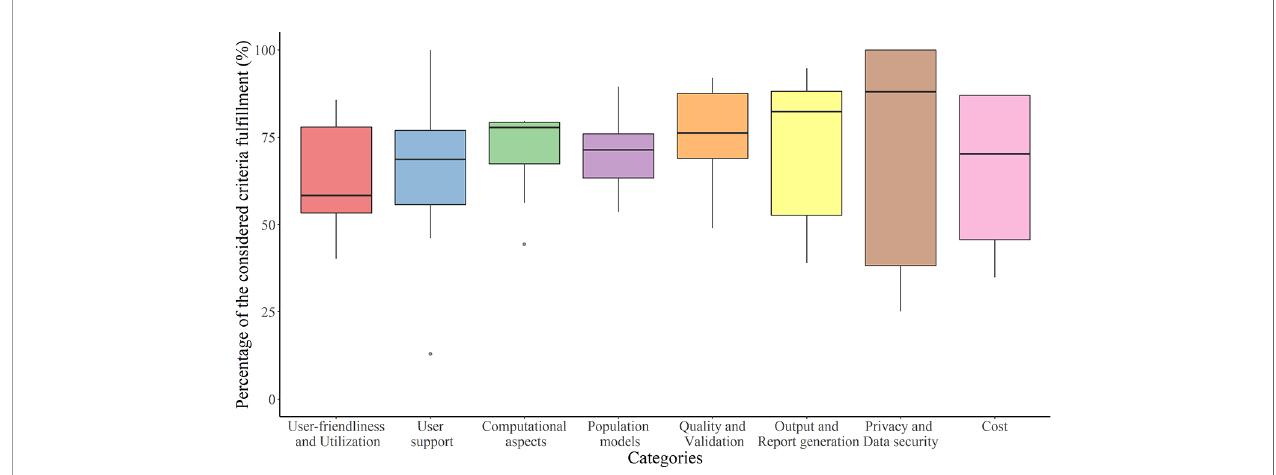
FIGURE 4 | Tukey boxplot representing ful fi llment of the considered criteria by the 10 evaluated software tools in each